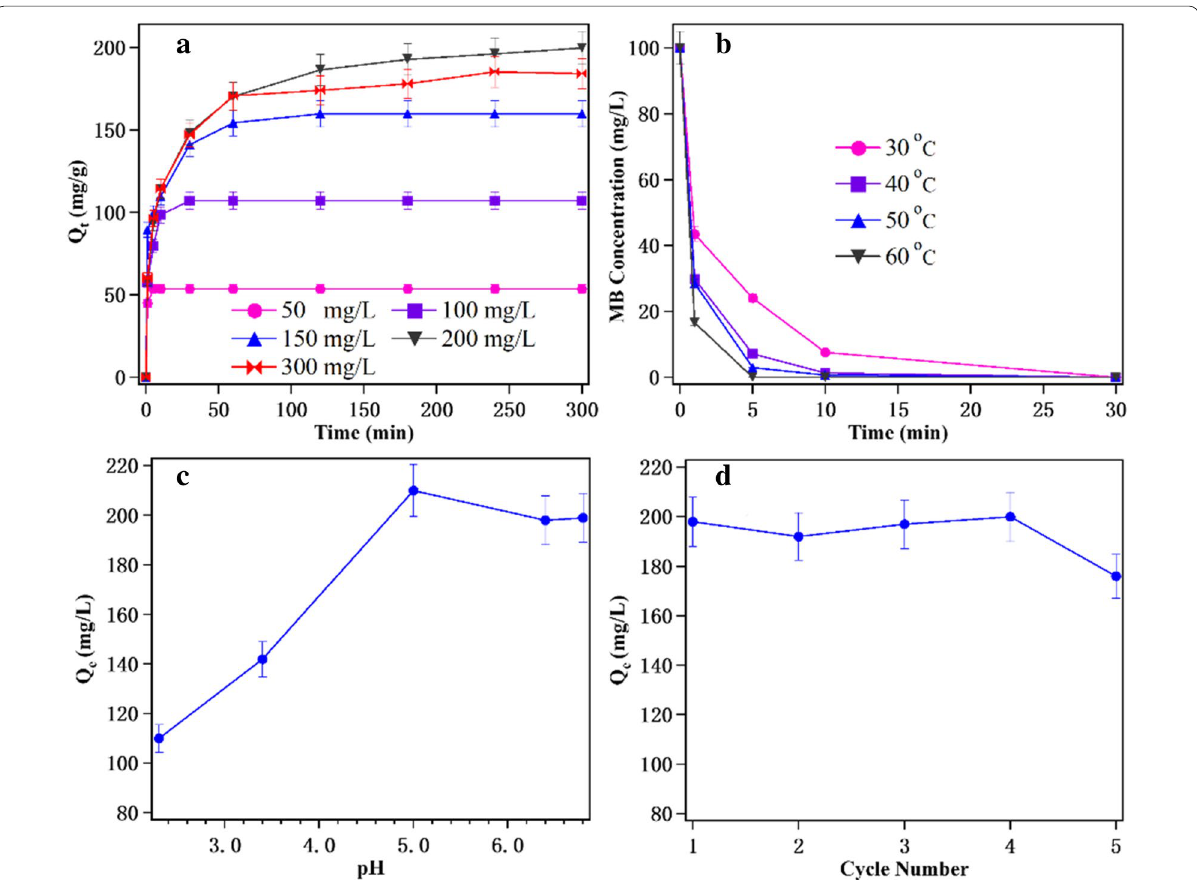
Fig. 7 Effect of initial concentration ( a ), temperature ( b ), solution pH ( b ) and reusability on remove of MB onto CS-H 2 SO4 conditions: a MB water solution volume is 75 mL with a pH value of 7, adsorbent dosage is 70 mg, 30 °C; b MB water solution volume 75 mL with a concentration of 100 mg/L with a pH value of 7, adsorbent dosage is 70 mg; c MB water solution volume 75 mL with a concentration of 300 mg/L, adsorbent dosage is 70 mg, 30 °C and 120 min; d MB water solution volume 75 mL with a concentration of 300 mg/L, adsorbent dosage is 70 mg, 30 °C and 120 min. The shake speed for each batch experiment is 120